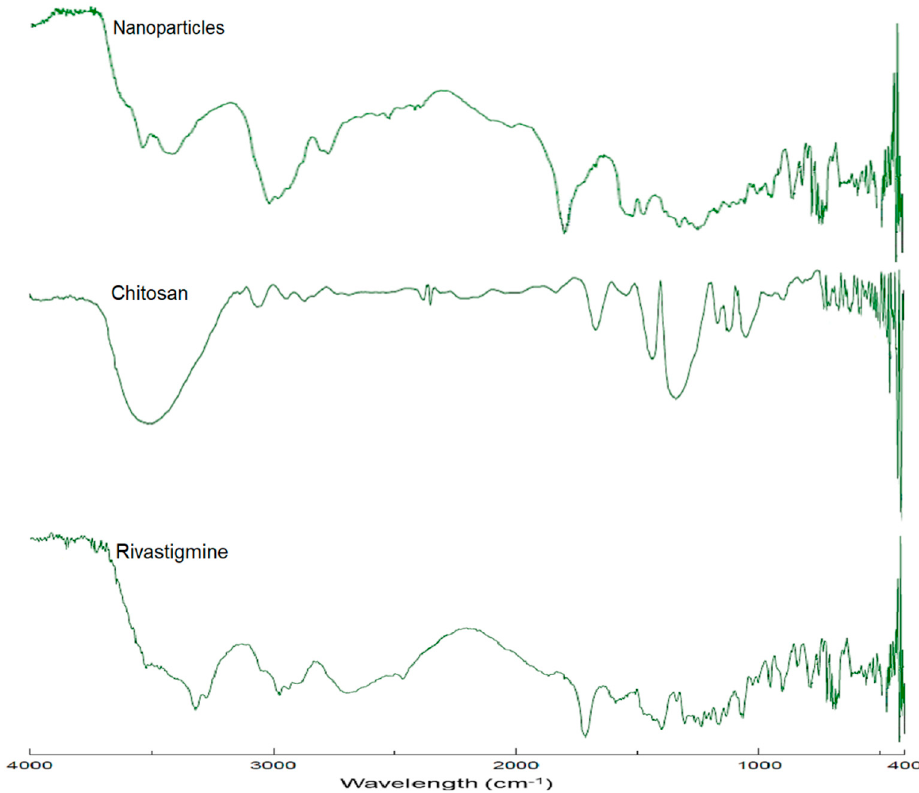
Figure 4. FTIR spectra of rivastigmine tartrate, chitosan, and rivastigmine-loaded nanoparticles (batch D8).